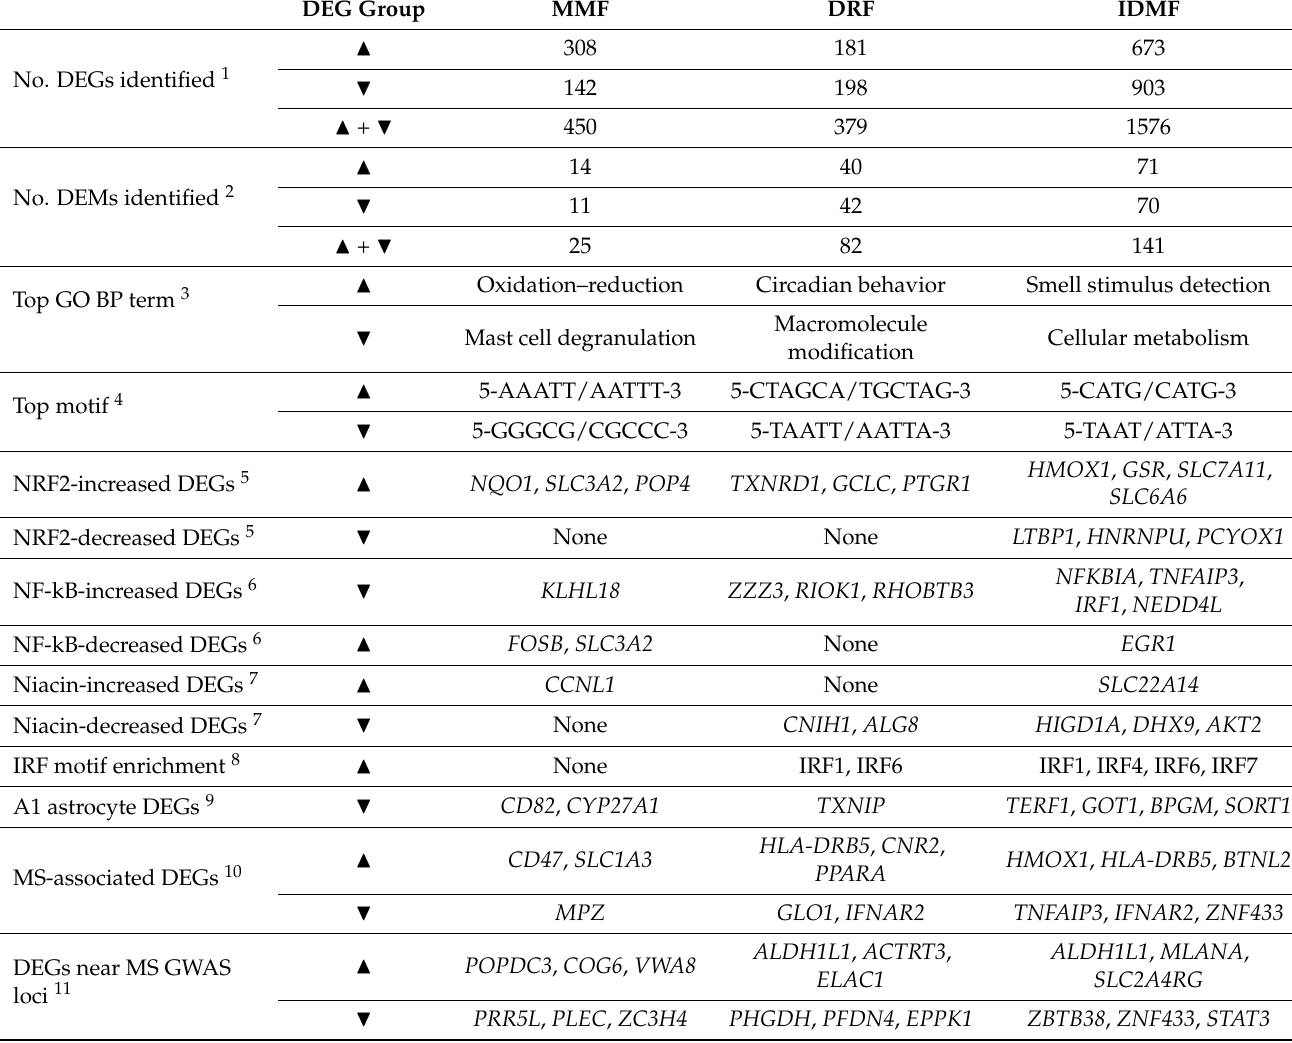
Table 1. Summary table. The table lists the number of DEGs identified ( p < 0.05 with FC > 1.25 or FC < 0.80), top biological process (BP) terms most strongly enriched among DEGs, top sequence motifs enriched in DEG 5 kb upstream regions, DEGs correspondingly regulated by NRF2 and niacin, DEGs inversely regulated by NF- κ B, IRF factors associated with enriched motifs in DEG upstream regions, A1 astrocyte marker down-regulated DEGs, MS-associated DEGs, and DEGs near MS GWAS loci. Results are summarized for increased DEGs ( (cid:78) ), decreased DEGs ( (cid:72) ), and the combined set of increased and decreased DEGs ( (cid:78) + (cid:72) ). See footnotes for further details. DEG Group MMF DRF IDMF